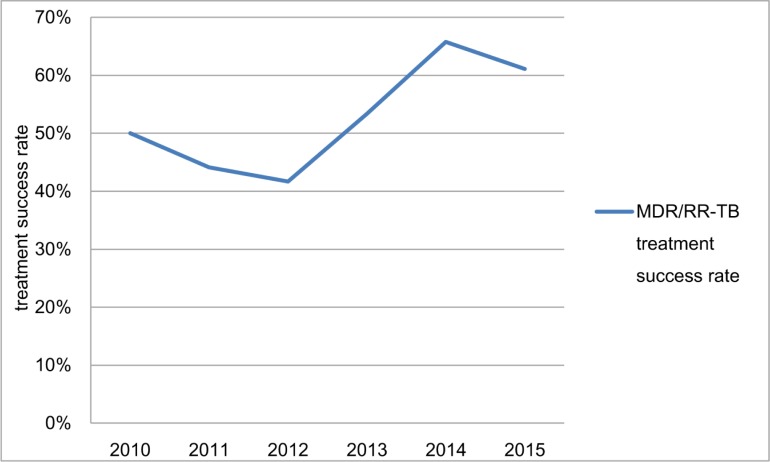
The MDR/RR-TB treatment outcome with imputed missing data.